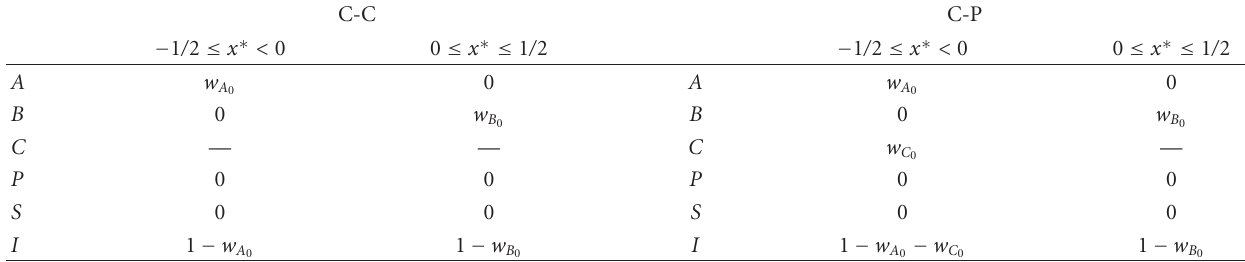
Table 3: General initial conditions for C-C and C-P reaction schemes at t ∗ = 0.